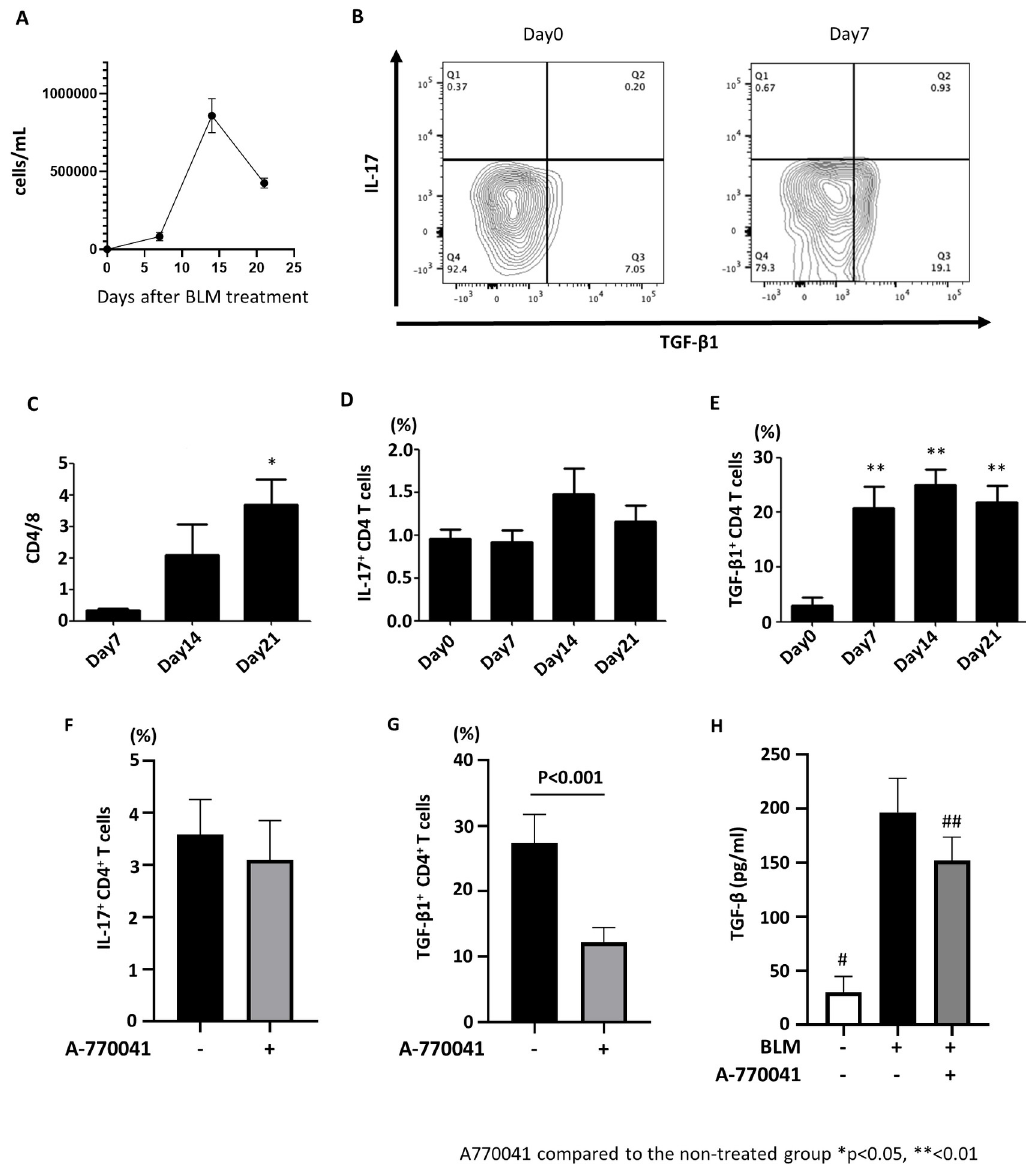
Fig 3. A-770041 reduces the percentage of TGF- β -producing CD4+ T-cells in BLM treated lungs. Mice received a single transbronchial instillation of 3.0 mg/kg BLM on Day 0, and BALF was collected on days 0, 7, 14, and 21. Lymphocyte counts (A) and the CD4/8 ratio (C) in the BALF were examined by flow cytometry (n = 5). The percentages of Il-17 + CD4 + T-cells and TGF- β 1 + CD4 + T-cells infiltrating lung tissues were examined by flow cytometry (B, D, E). After BLM treatment, A-770041 (5 mg/kg/ day) or vehicle was administered daily, and lungs were collected on day 7 (n = 5). The percentages of Il-17+ CD4+ T-cells and TGF- β 1 + CD4 + T-cells infiltrating lung tissues with or without A-770041 were examined by flow cytometry (F, G). The concentration of TGF- β in BALF was examined by an ELISA. � : p < 0.05 versus samples of day 7; �� : p < 0.01 versus samples of day 0; #: p < 0.01 versus group treated with BLM without A-770041; ##: p < 0.05 versus group treated with BLM without